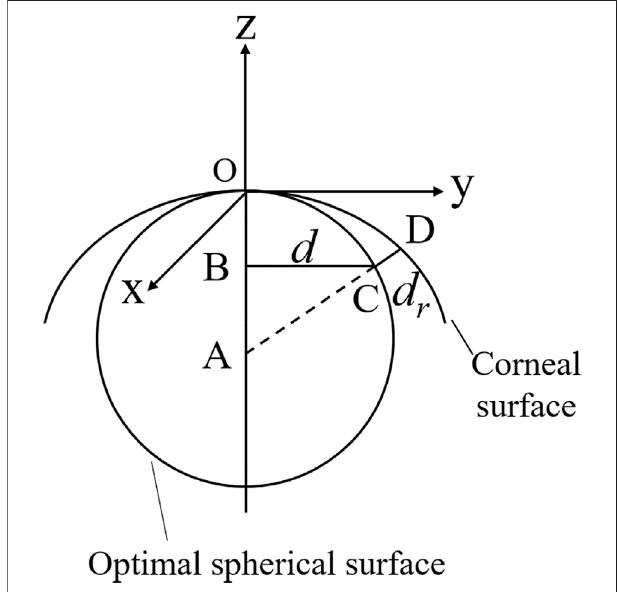
FIGURE 1 | Diagram for the coordinates of the anterior corneal